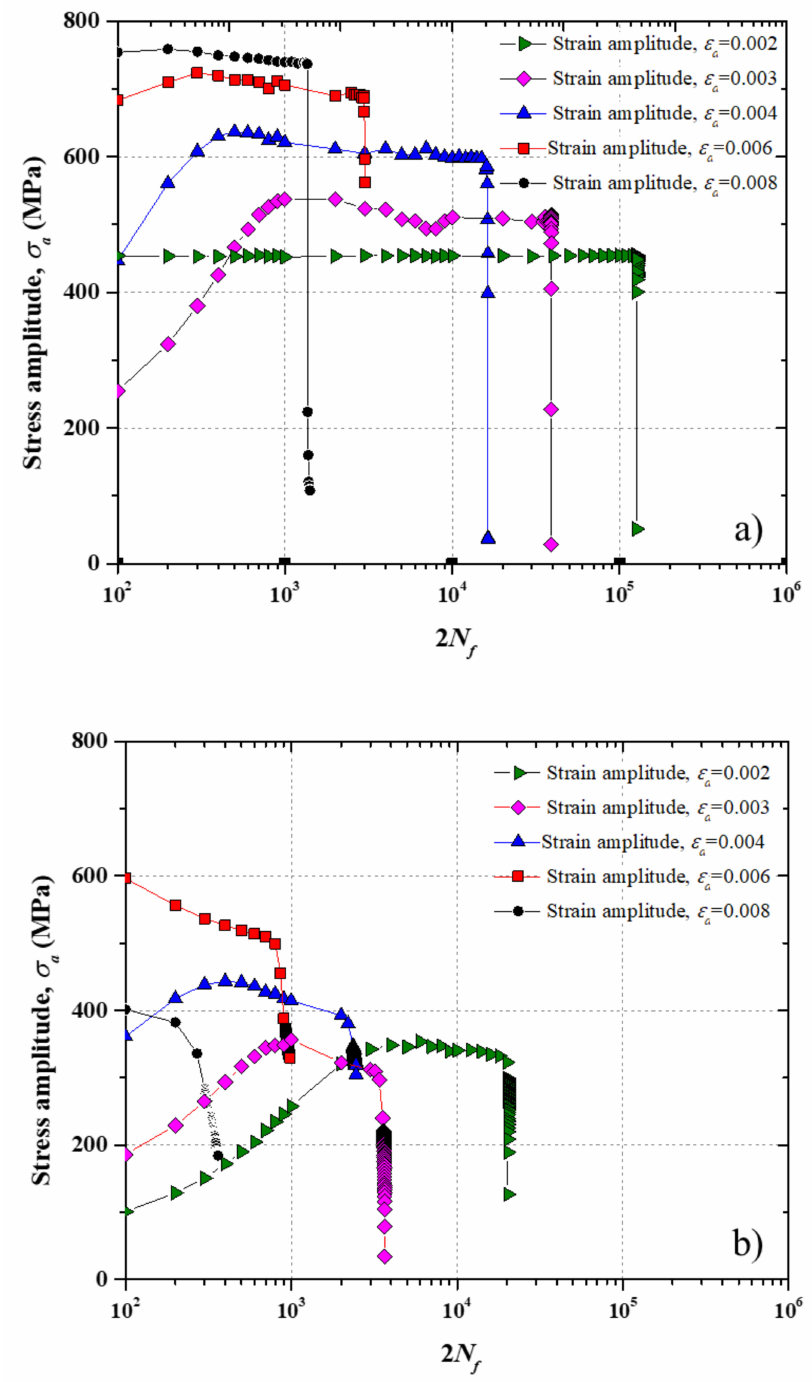
Figure 13. Variable stress amplitude vs. number of cycles at different strain amplitudes for: ( a ) DP980 steel sheet and ( b ) welded